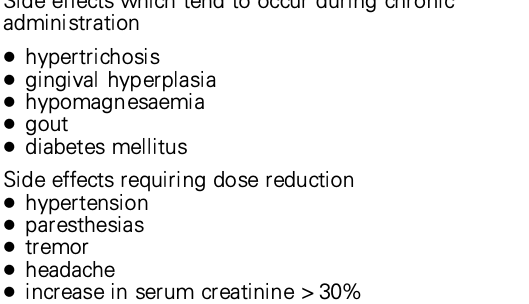
Table 1. Side effects of cyclosporine Side effects which tend to occur during chronic